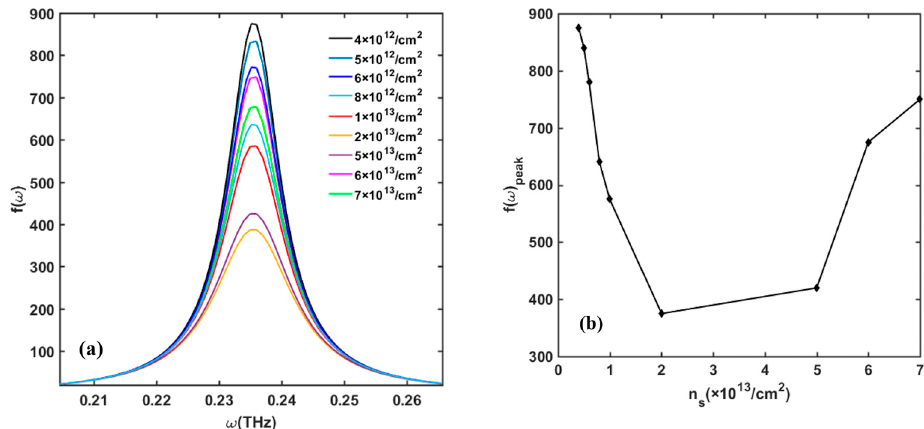
Figure 5. ( a ) Variation in f( ω ) with 2DEG density n s in frequency range of 0.1–10 THz at temperature of 77 K. ( b ) Peak value of f( ω ) with change in n s . Other parameters are taken as N dis = 10 10 /cm 2 , Δ = 1 nm, and Λ = 10 nm.